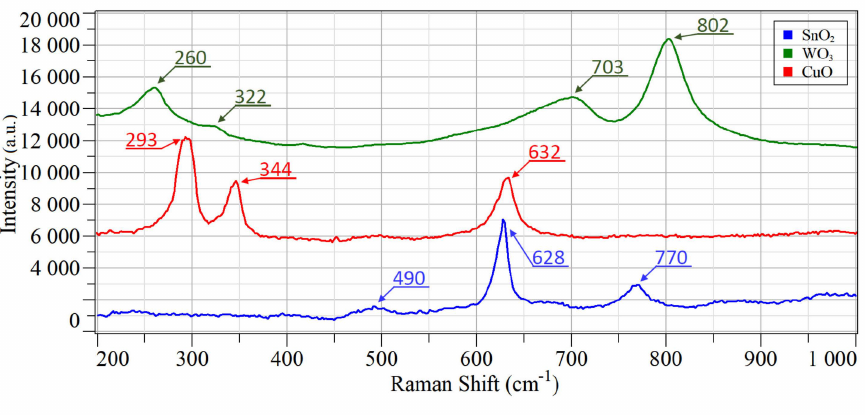
Figure 5. Raman spectra of SnO 2 , WO 3 , and CuO nanowires deposited on µ